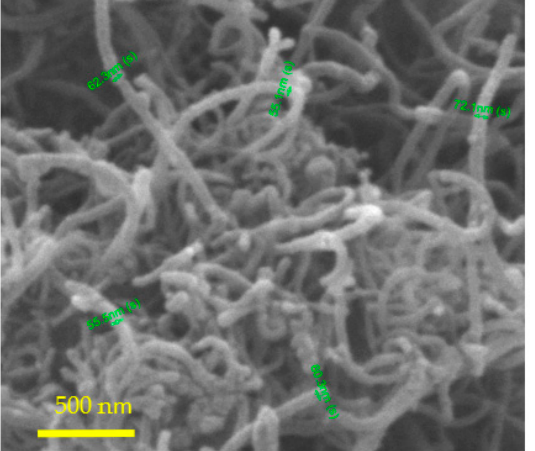
Figure 3. SEM images of MWCNTs prepared with the supported catalyst approach (Catalyst: Fe/zeolite; carbon source: acetylene).